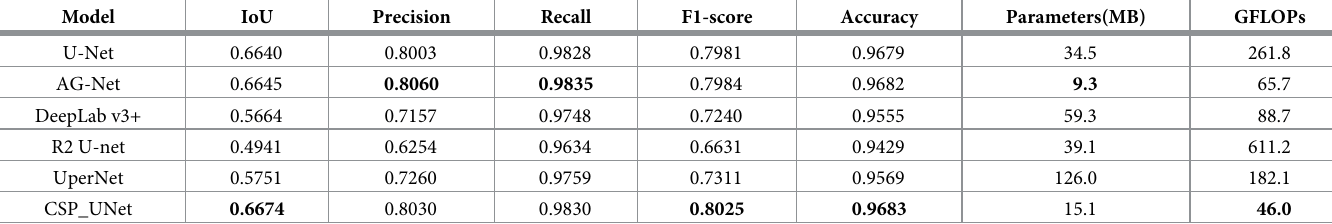
Table 5. Experimental results of CSP_UNet compared with other segmentation models.